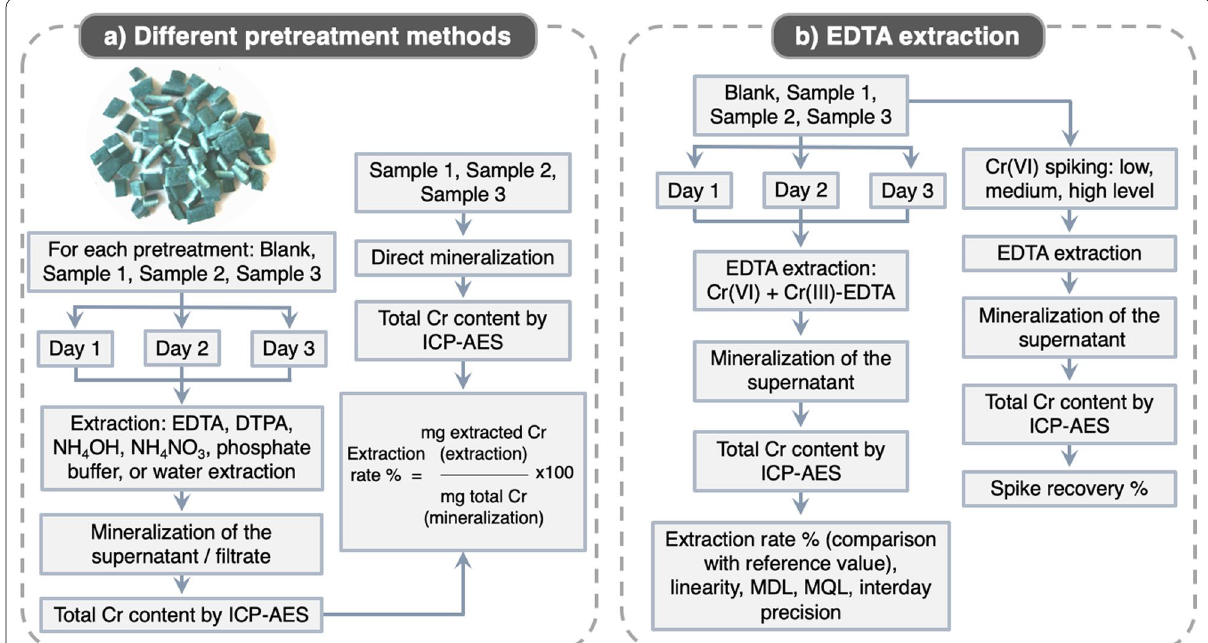
Fig. 1 Scheme of the methodology for: a chromium extraction by different pretreatment methods; b EDTA extraction (sample spiking